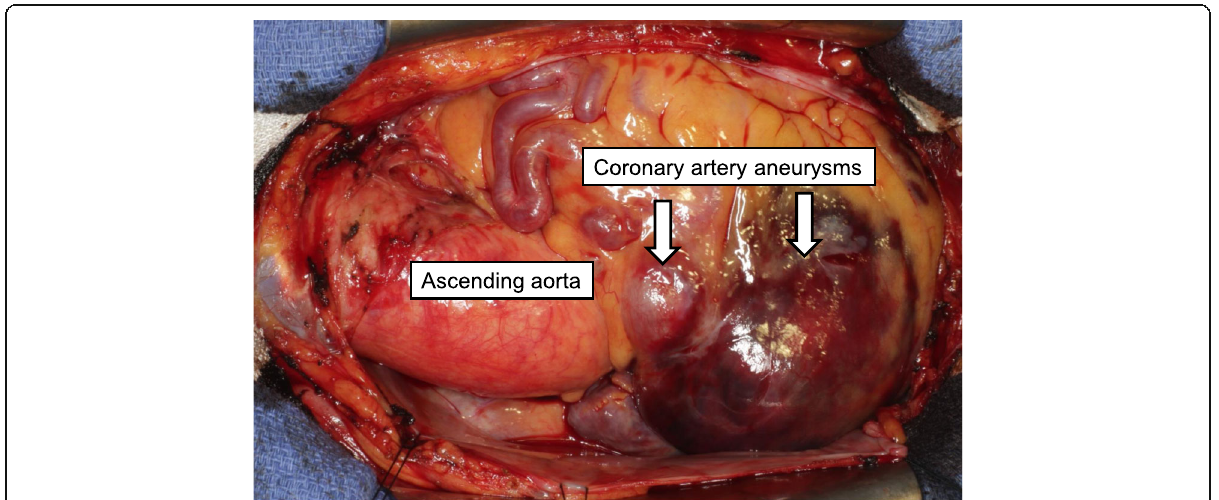
Fig. 3 Intraoperative photograph. Aneurysms (arrows) originating from the ostium of the right coronary artery. Blood oozing is evident and a rupture site is located on the wall of the giant coronary artery aneurysm